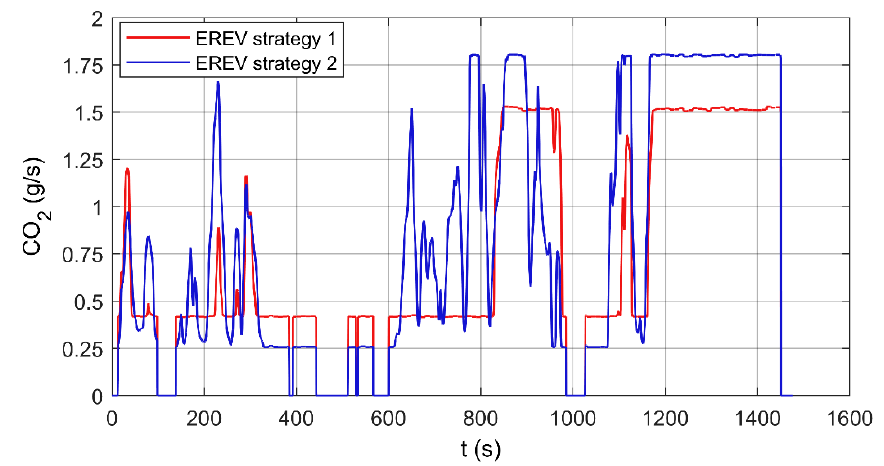
Figure 15. CO 2 emission intensity in one simulated driving cycle for extended range electric vehicle (EREV) operation for two range extender control strategies.